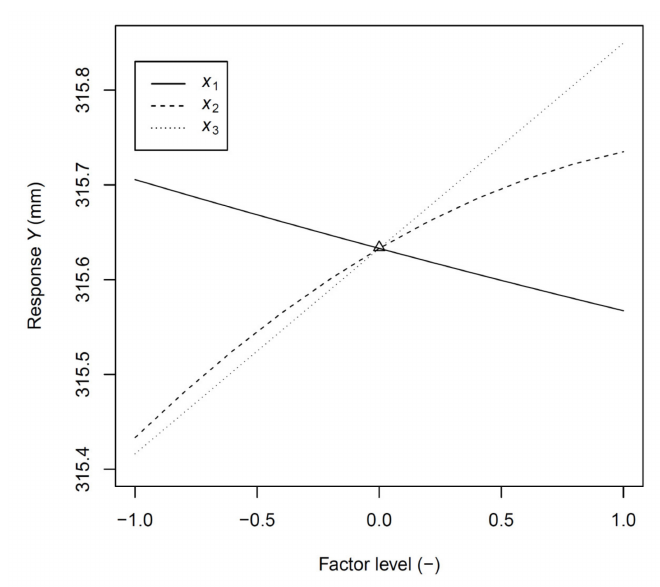
Figure 13. Influence of individual factors on the resulting Response Y .